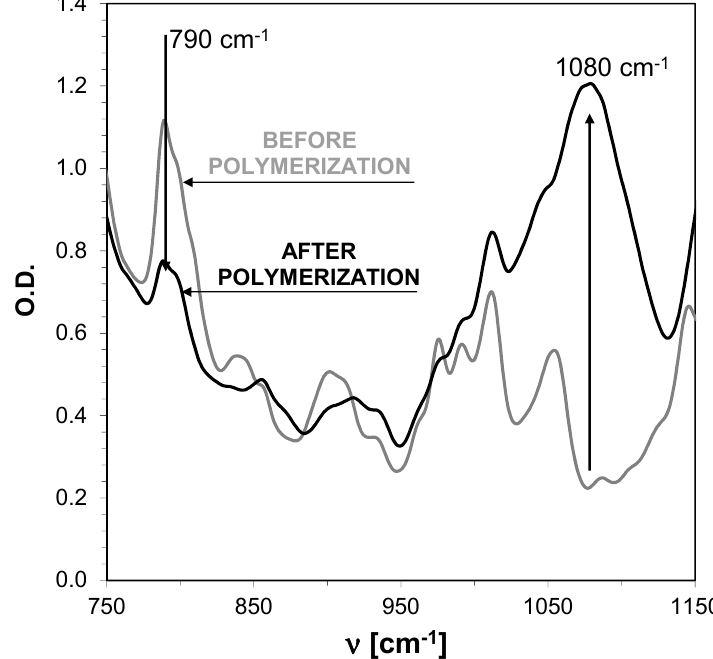
Figure 10. FTIR spectra of C-H bonds band in oxirane ring before and after photopolymerization of CADE under UV-LED 365 nm (190 mW/cm 2 ) irradiation in composition with S5.